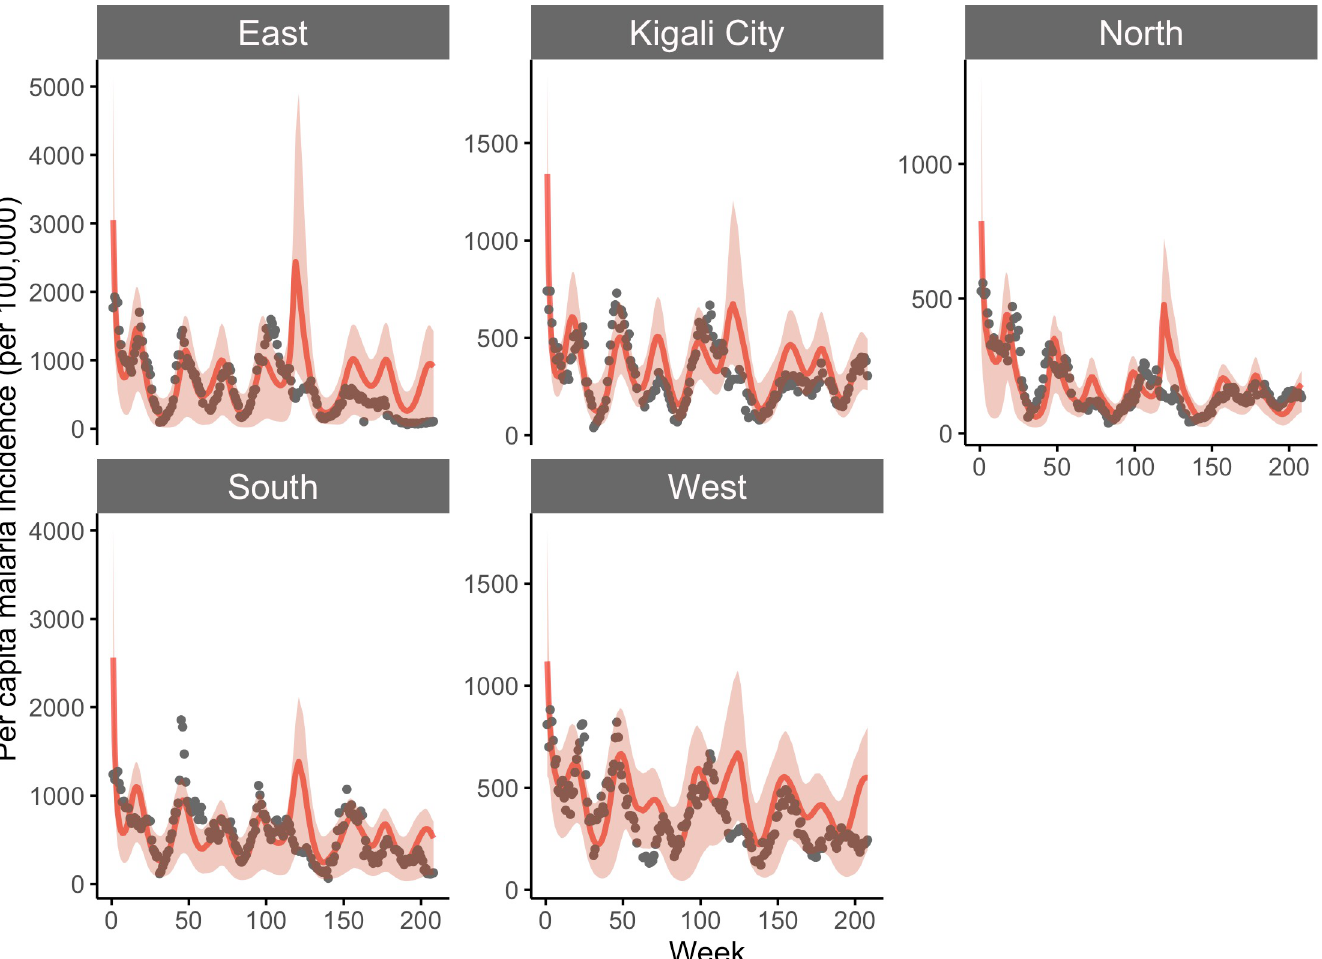
Fig 1. Model-EAKF simulated incidence of malaria at the province level from 2016–2019. The aggregated results (per capita incidence) from simulations of malaria transmission using the model-EAKF system. Model predictions are shown in red lines, with red shading indicating the 95% credible interval (CI) of model estimated incidence, and reported incidence is shown as gray dots. Note that the range of y-axes for model simulated and reported malaria differ among panels.